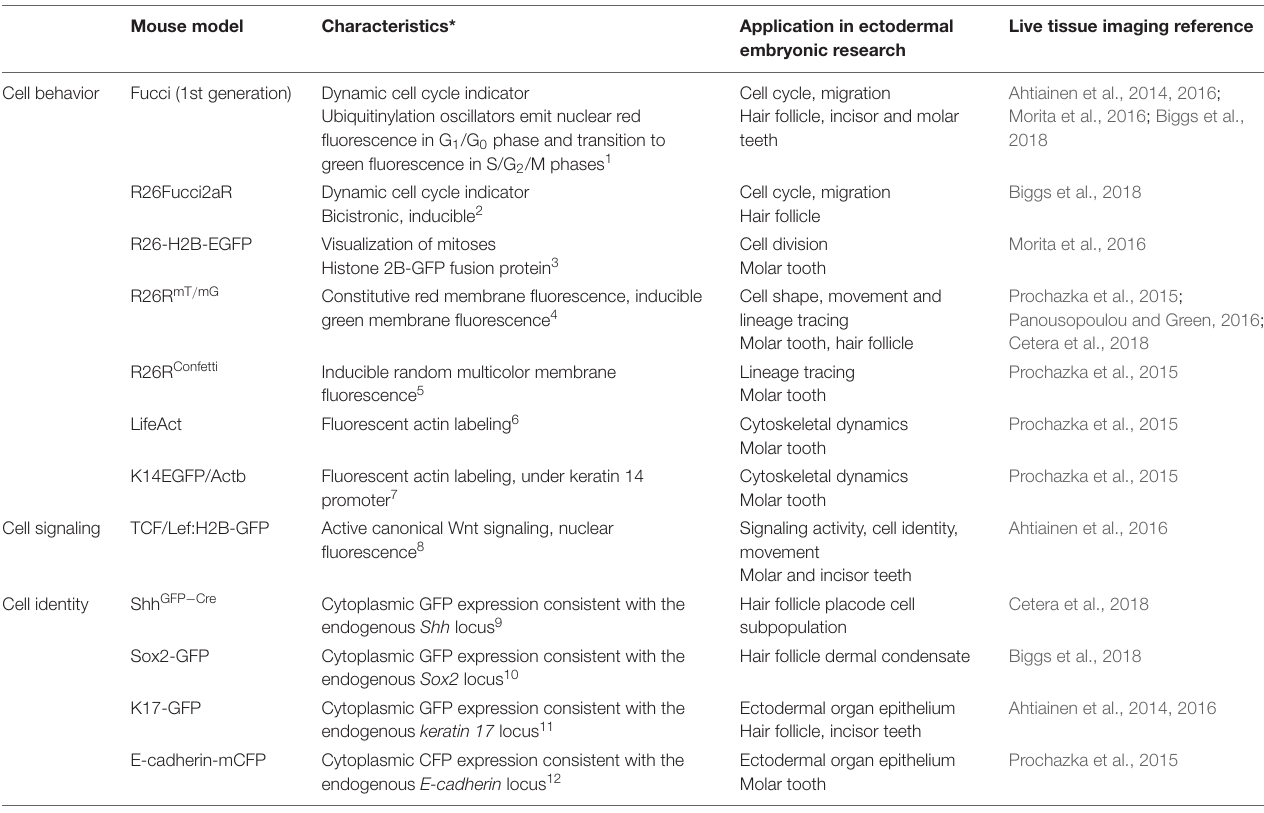
TABLE 1 | Fluorescent mouse reporter models for live tissue imaging of ectodermal